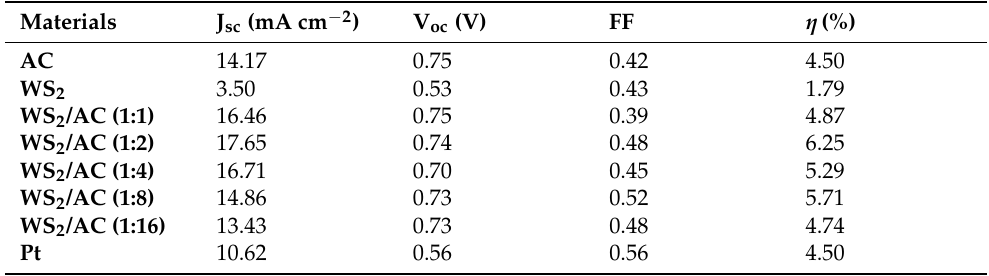
Table 1. Performance of various cells made with WS 2 , AC, and a combination of both with different ratios.